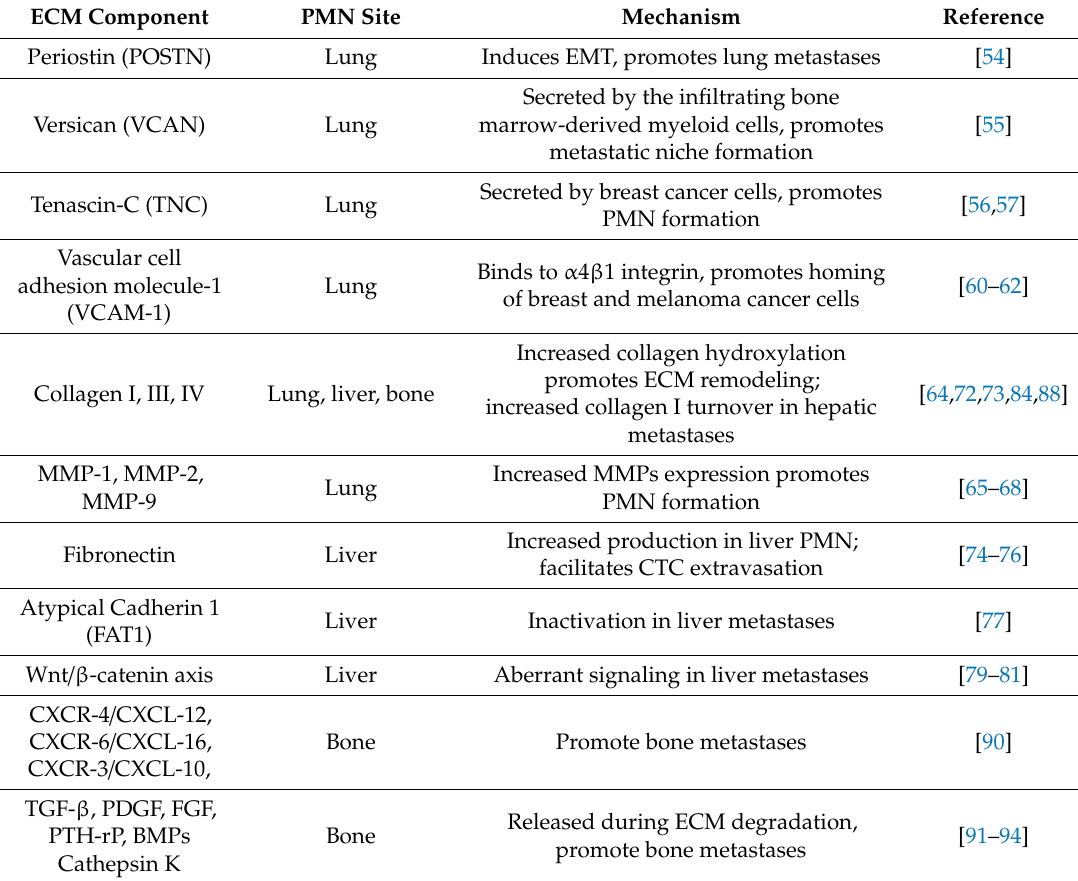
Table 2. Major ECM components or mediators involved in pre-metastatic niche (PMN) formation in lung, liver and